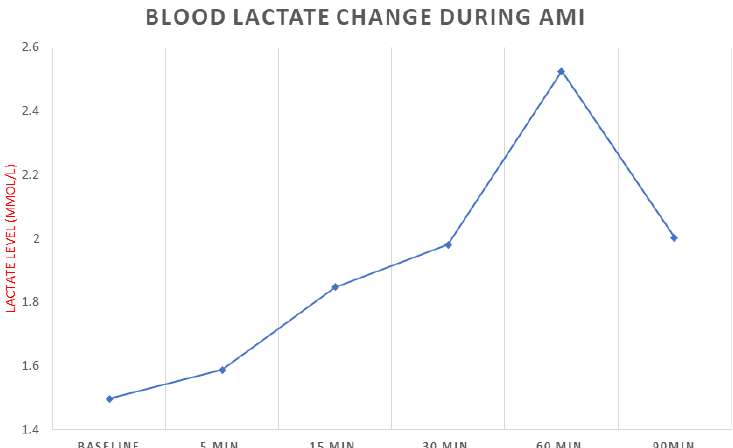
Figure 3. Blood lactate levels at baseline and during the occlusion period in pigs.